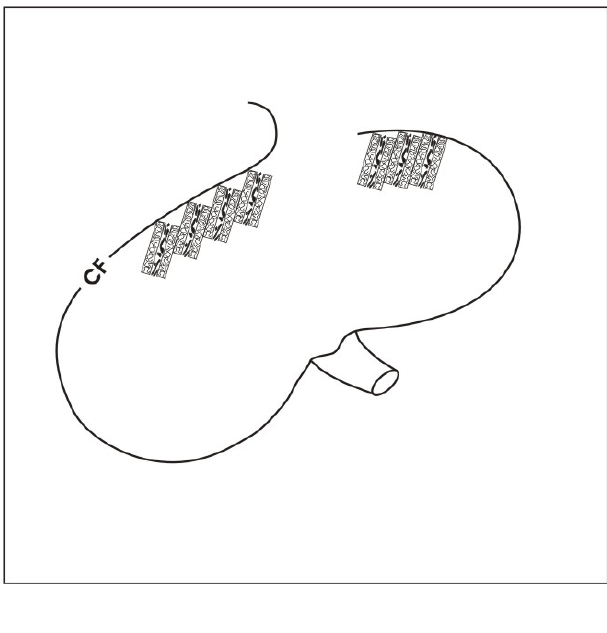
Figure 12. Schematic illustration of possible implantation site. Basic sandwich set-ups can be stacked underneath the renal capsule. At this specific site, nephrogenesis has been terminated once the growing kidney has reached its final size. The idea is to re-activate the site of nephrogenesis by the implantation of renal stem/progenitor